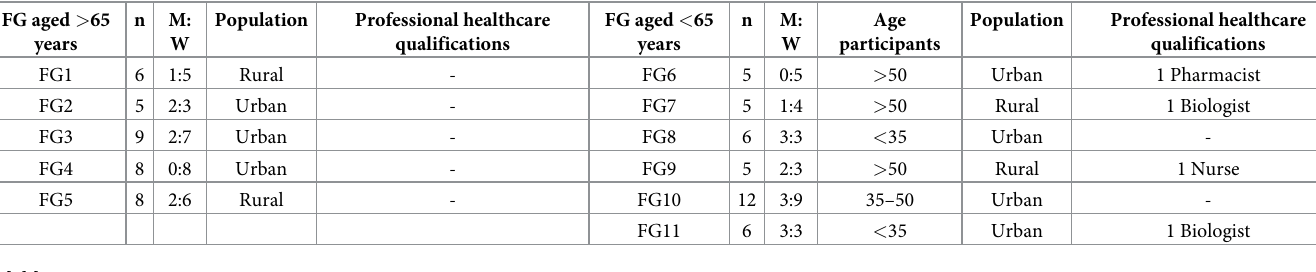
Table 1. Focal group